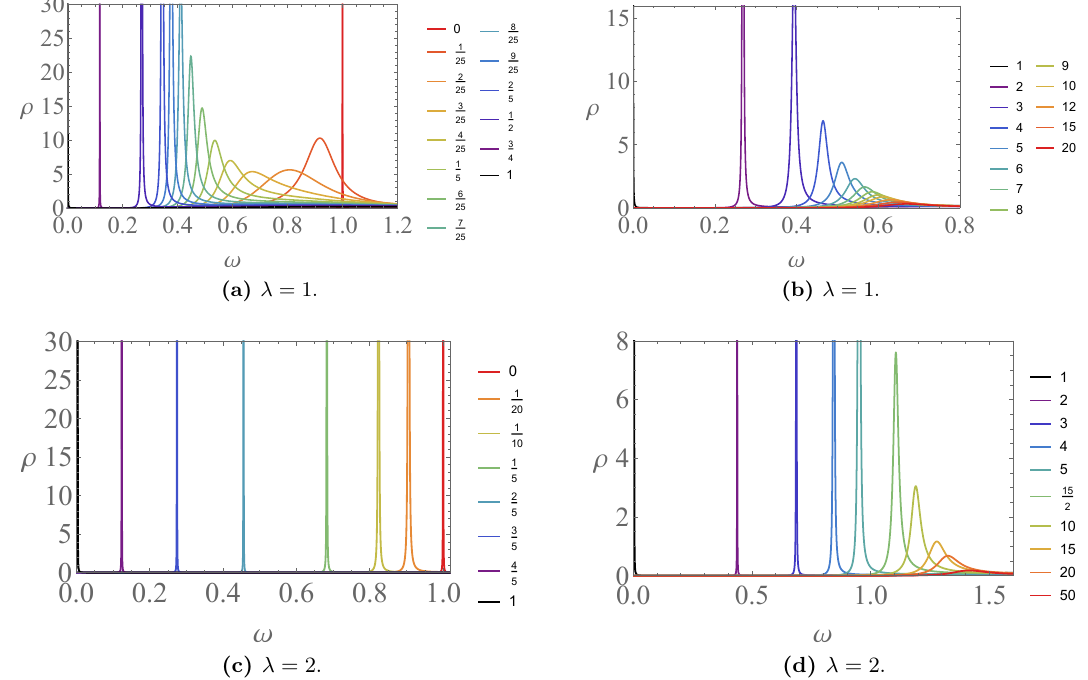
Figure 5 . The semiholographic spectral function at zero momentum for several values of g . The legends show the value of g=g c . In (a) and (b), (cid:21) = 1 and g c = 0 : 56. In (c) and (d), (cid:21) = 2 and g c = 0 : 39. These spectral functions are symmetric in ! due to particle-hole symmetry. In (c) the peaks are all very sharp because they are at frequencies inside the gap of the self-energy for (cid:21) = 2. Referring to appendix B for details, we note that Z